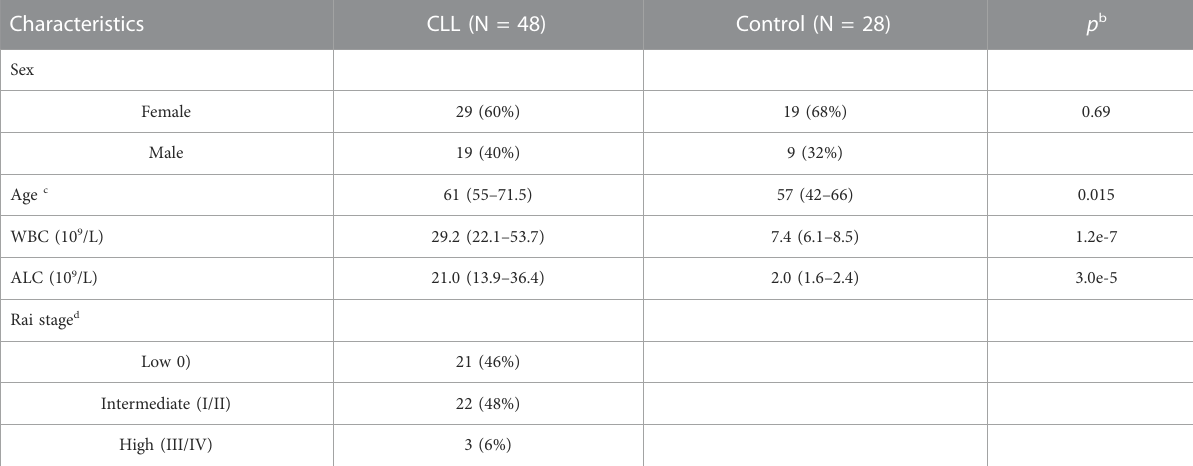
TABLE 1 Characteristics of the 76 subjects in this study. a